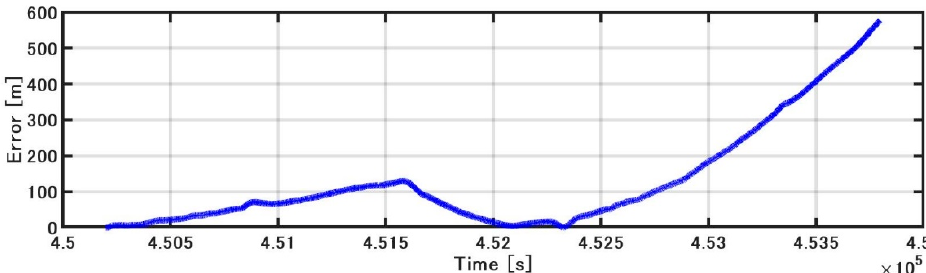
Figure 16. Horizontal error.